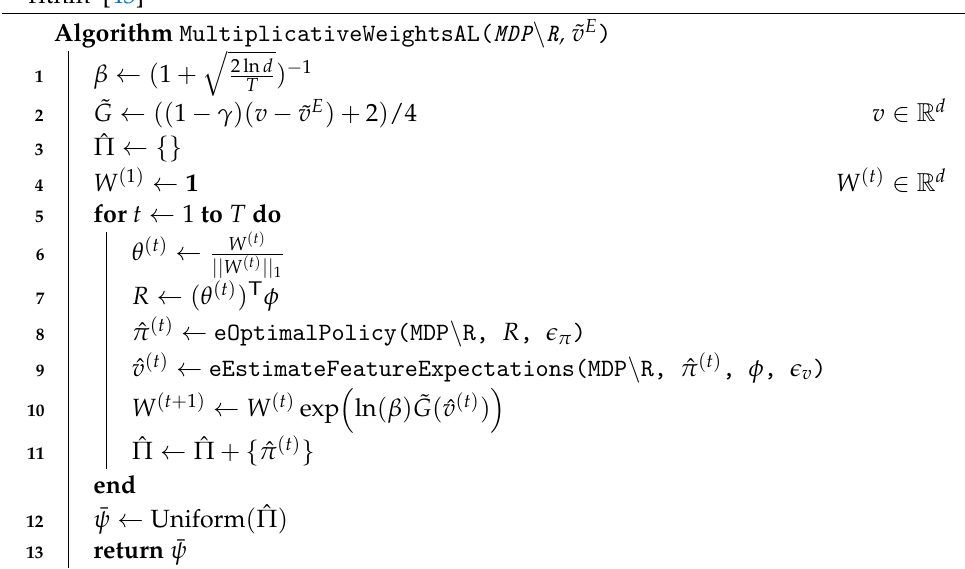
Algorithm 3: Multiplicative Weights Apprenticeship Learning (MWAL) Algo- rithm [43] Algorithm MultiplicativeWeightsAL( MDP \ R , ˜ v E